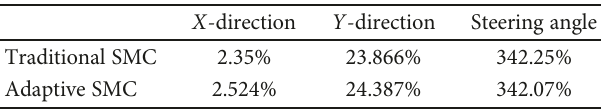
Figure 12: The value changes of the adaptive functions. Table 2: The comparison of accumulated absolute error ratios from SMC tracking a cosine